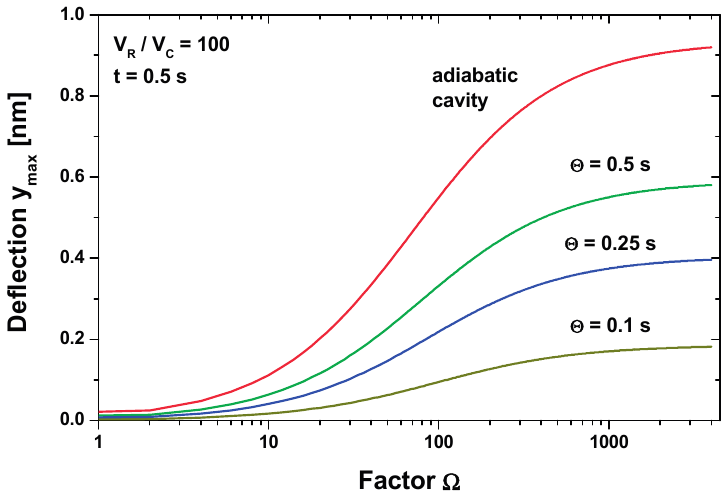
Figure 11. Maximum central deflection, y max , of a circular membrane (silicon, 1 µm thickness) as a function of the factor Ω and heat loss time constant Θ for a water-filled cavity. IR power density: 10 W/m 2 , irradiation time: 0.5 s, diameter and height of the cavity: 0.5 mm, Volume reservoir: 100 × volume of